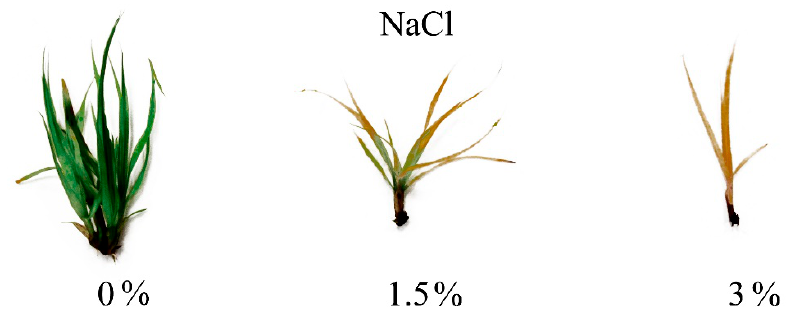
Figure 2. Growth of explants on the medium supplemented with NaCl after 4 weeks of cultivation.